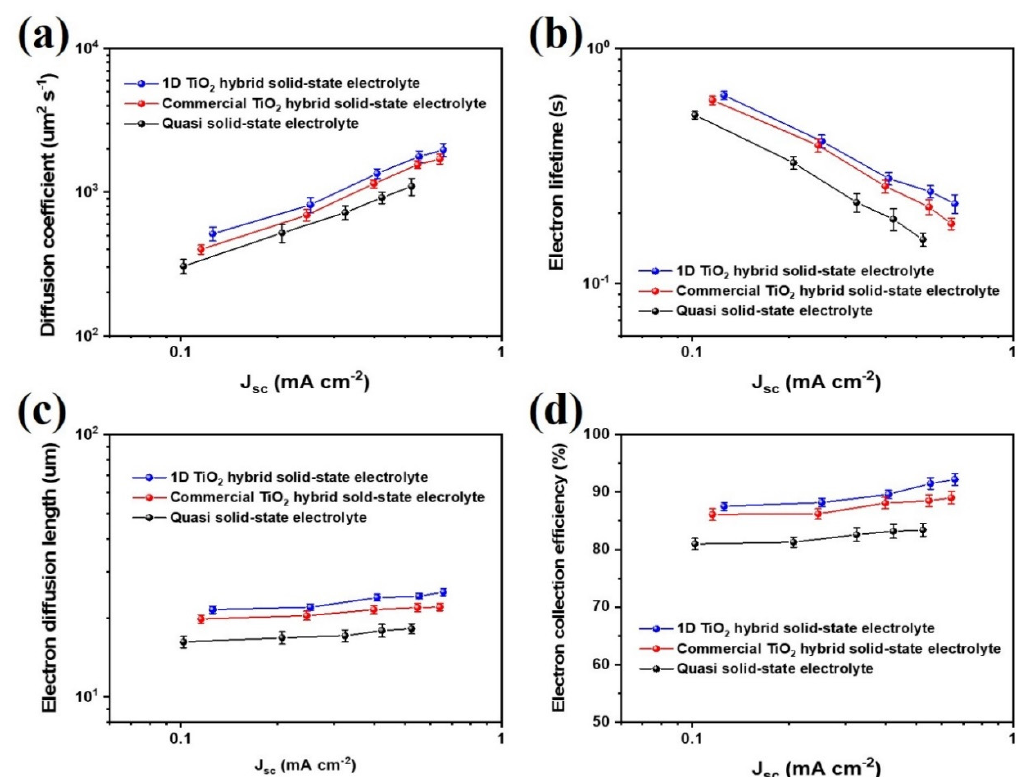
Figure 4. ( a ) Diffusion coefficients ( D n ), ( b ) recombination time ( τ r ), ( c ) electron diffusion length ( L n ), and ( d ) electron collection efficiency ( η cc ) as functions of the J sc for the mesoporous carbon-based dye-sensitized solar cells (DSSCs) with quasi solid-state electrolyte, commercial TiO 2 hybrid solid-state electrolyte and 1D TiO 2 hybrid solid-state electrolyte measured by IMPS and IMVS. Error bars represent the standard deviation of at least 5 cells. Nanomaterials 2021 , 11 , x FOR PEER REVIEW